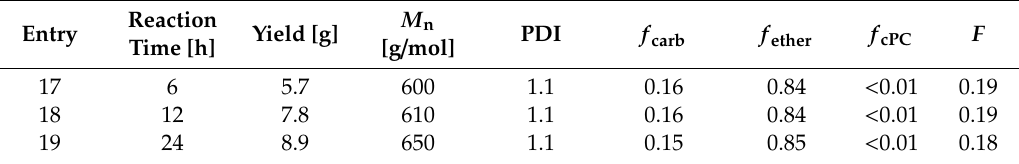
Table 3. Calculated F and determined cPC content in PPEC (PDI = 1.1) synthesized at 60 ◦ C and 18.9 bar CO 2 pressure ( N =